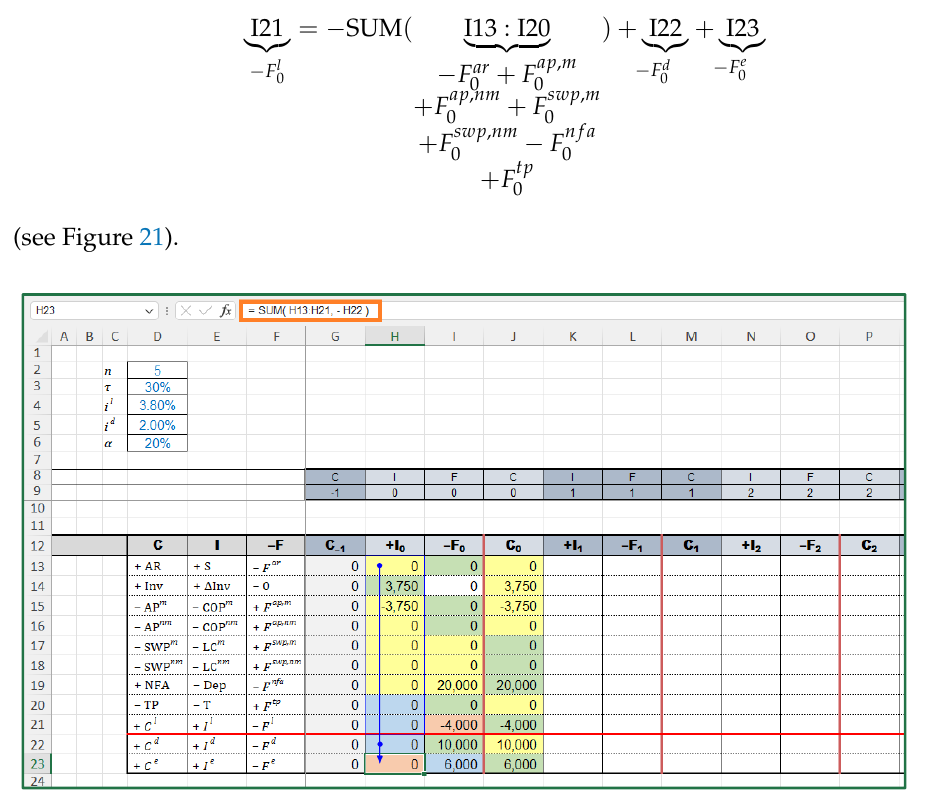
Figure 20. The cells whose values are calculated with the law of conservation are shown in pink orange. Cell H23 reports the net income (“SplitScreenStrip” sheet). (The cells whose values are provided in “PreCalc” are in yellow, the cells whose values are calculated with the law of motion are in green, the cells whose values are calculated via suitable formulas are in blue, and the cells whose values are calculated with the law of conservation are in pink orange).